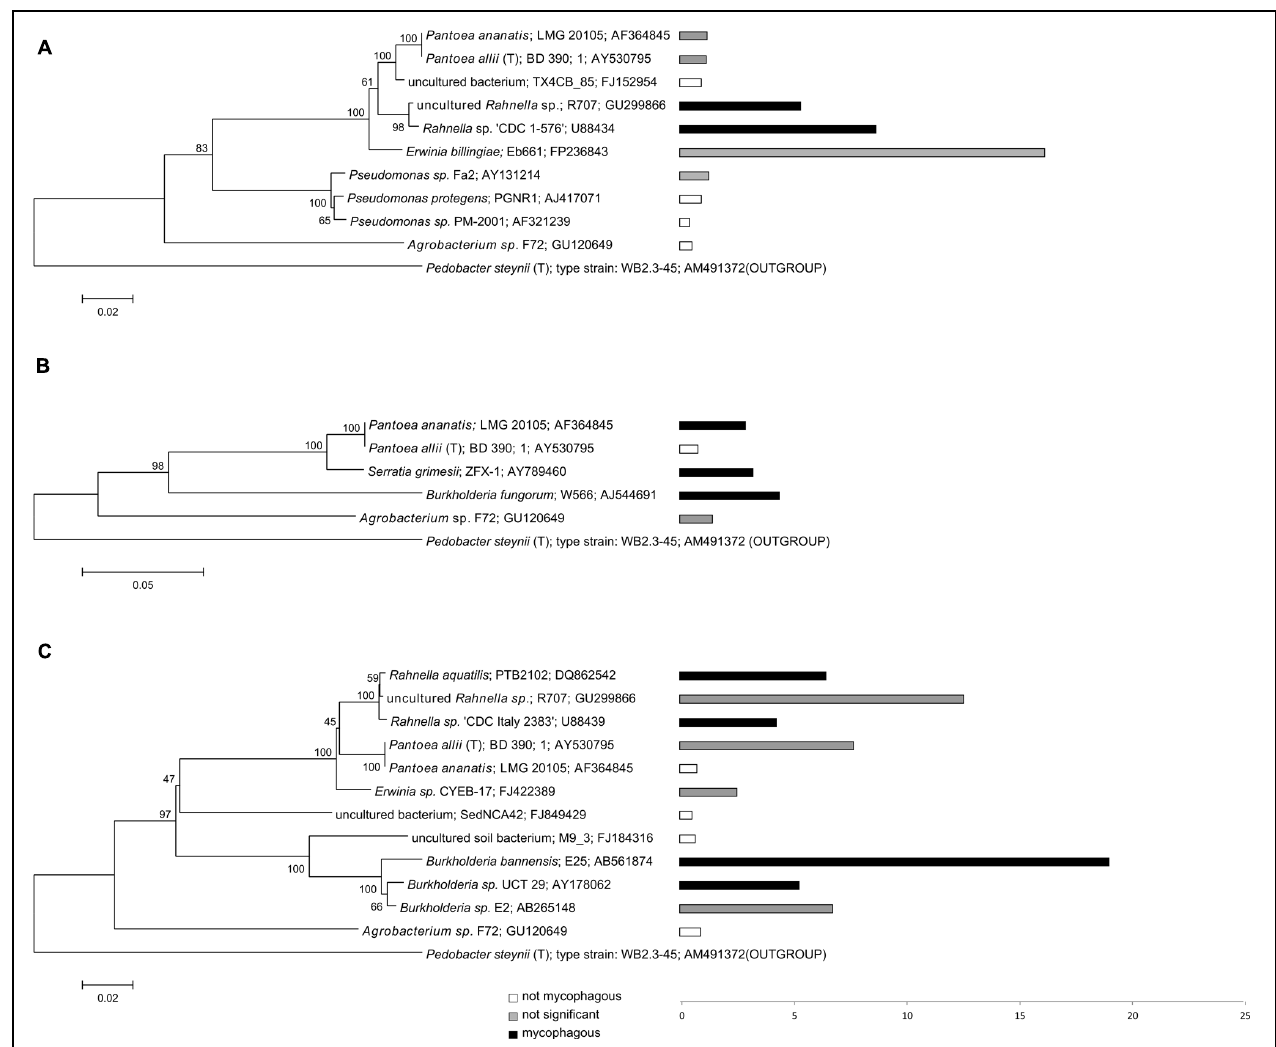
FIGURE 3 | Phylogeny and potential mycophagous ability of antifungal, hyphae-adhering bacteria retrieved with the “transfer-enrichment” approach. The indicated bacterial strains are cultured or uncultured bacteria that have the closest match to one or several of the antifungal, hyphae-adhering bacterial isolates. Separate trees are presented for bacteria associated with (A) T. harzianum, (B) M. hiemalis and (C) R. solani . Bars indicate measured mycophagy ratios: black bars representing bacteria demonstrating significant mycophagous growth (ratio > 1; P < 0.05), gray bars representing bacteria with possible mycophagous growth (ratio > 1; P > 0.05), and white bars represent bacteria with no mycophagous growth (ratio ≤ 1).